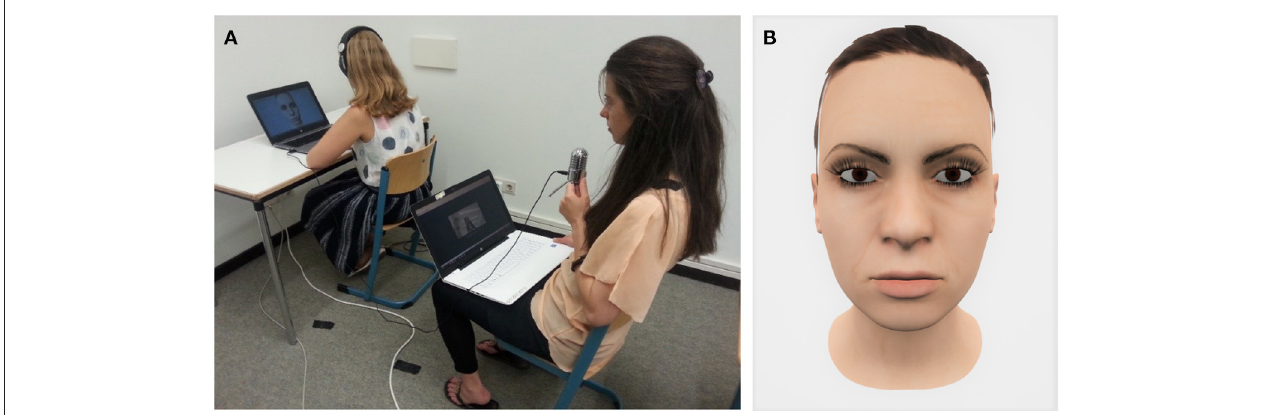
FIGURE 2 | Experimental setup (A) and screenshot of the virtual avatar (B) . The participant sat in front of a computer screen displaying the virtual avatar. Via headphones, the participant could hear the experimenter speaking into a microphone. Throughout CAT-DB, the experimenter’s facial expressions and lip movements were captured and translated onto the virtual avatar’s face in real time.